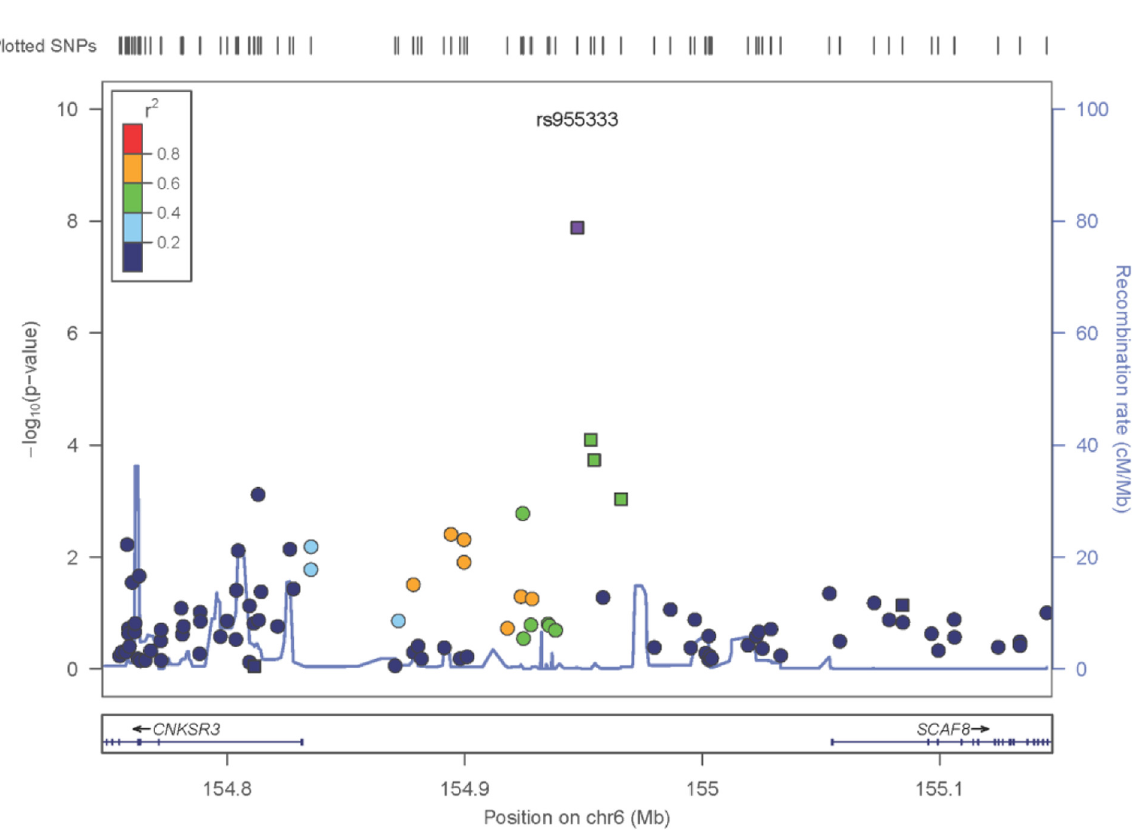
Fig 2. Zoom plot of the SCAF8 gene region (trans-ancestry meta-analysis across Discovery and Replication samples). Squares denote SNPs in the Replication Study, Circles are SNPs that are only present in the GWAS, so the P-values shown reflect the GWAS Trans-Ancestry Meta-Analysis. The Ad- Mixed American population in 1000 Genomes was used for LD information.